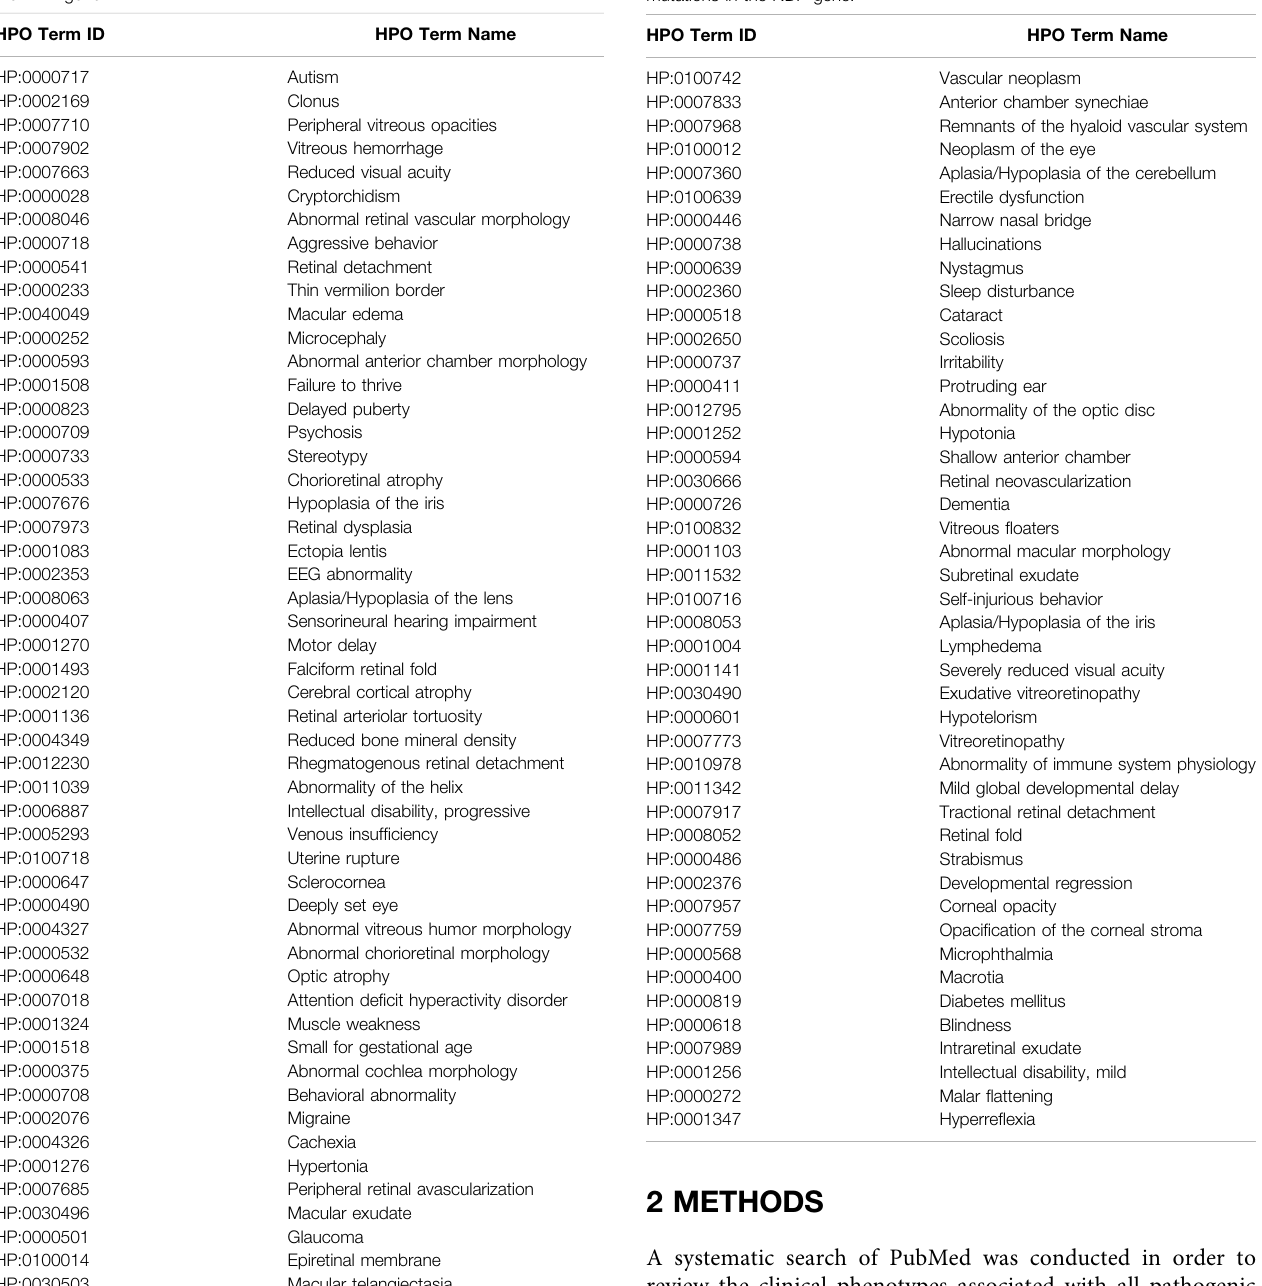
TABLE 3| Human Phenotype Ontology (HPO) terms associated withmutationsin the NDP